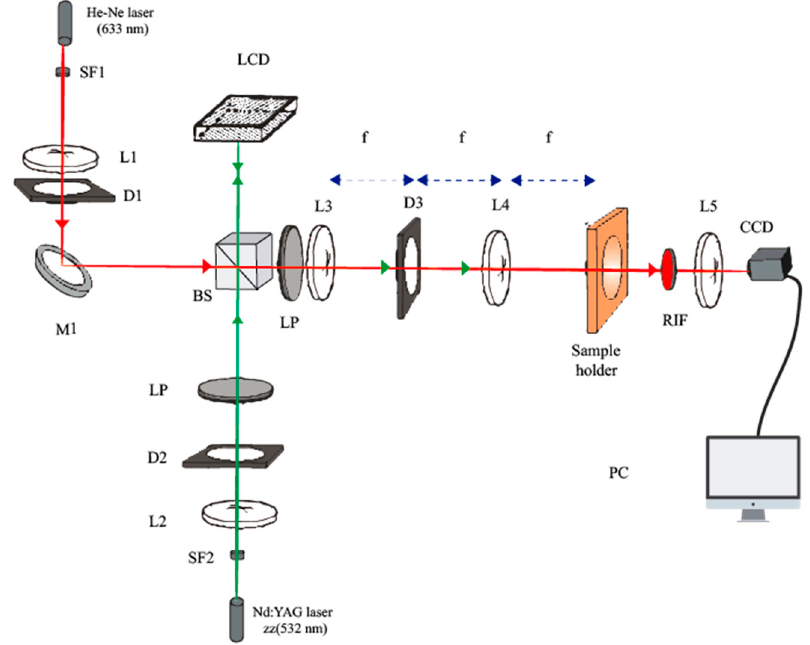
Figure 4. Experimental setup. BS: beam splitter, Mi: mirror, SFi: spatial filter, LP: lineal polarizer, Li: lens, Di: diaphragm, RIF: red interference filter and PC: data recorder.